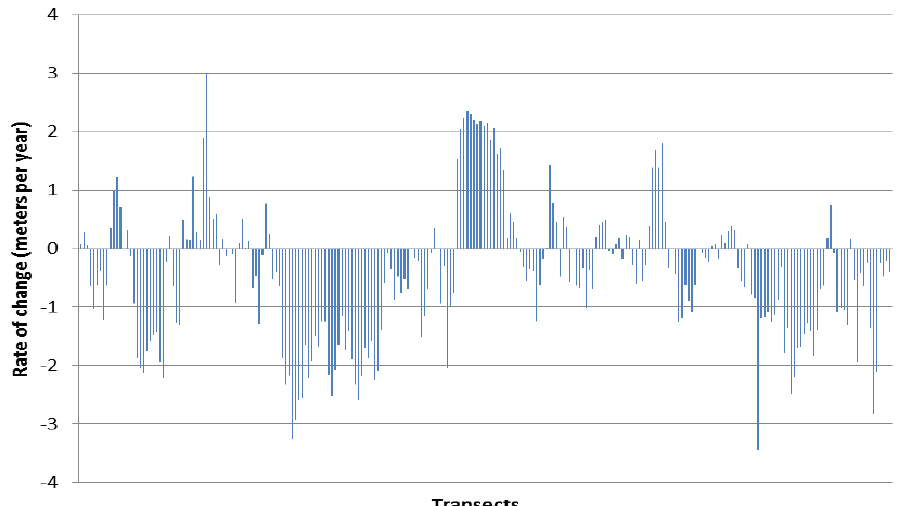
Figure 2. Rate of change results from 246 transects across the seaward edge of mangroves, Cameroon Estuary, 1975 (cid:177) 2007. A negative rate of change shows mangrove retreat, while a positive rate of change shows mangrove advance or